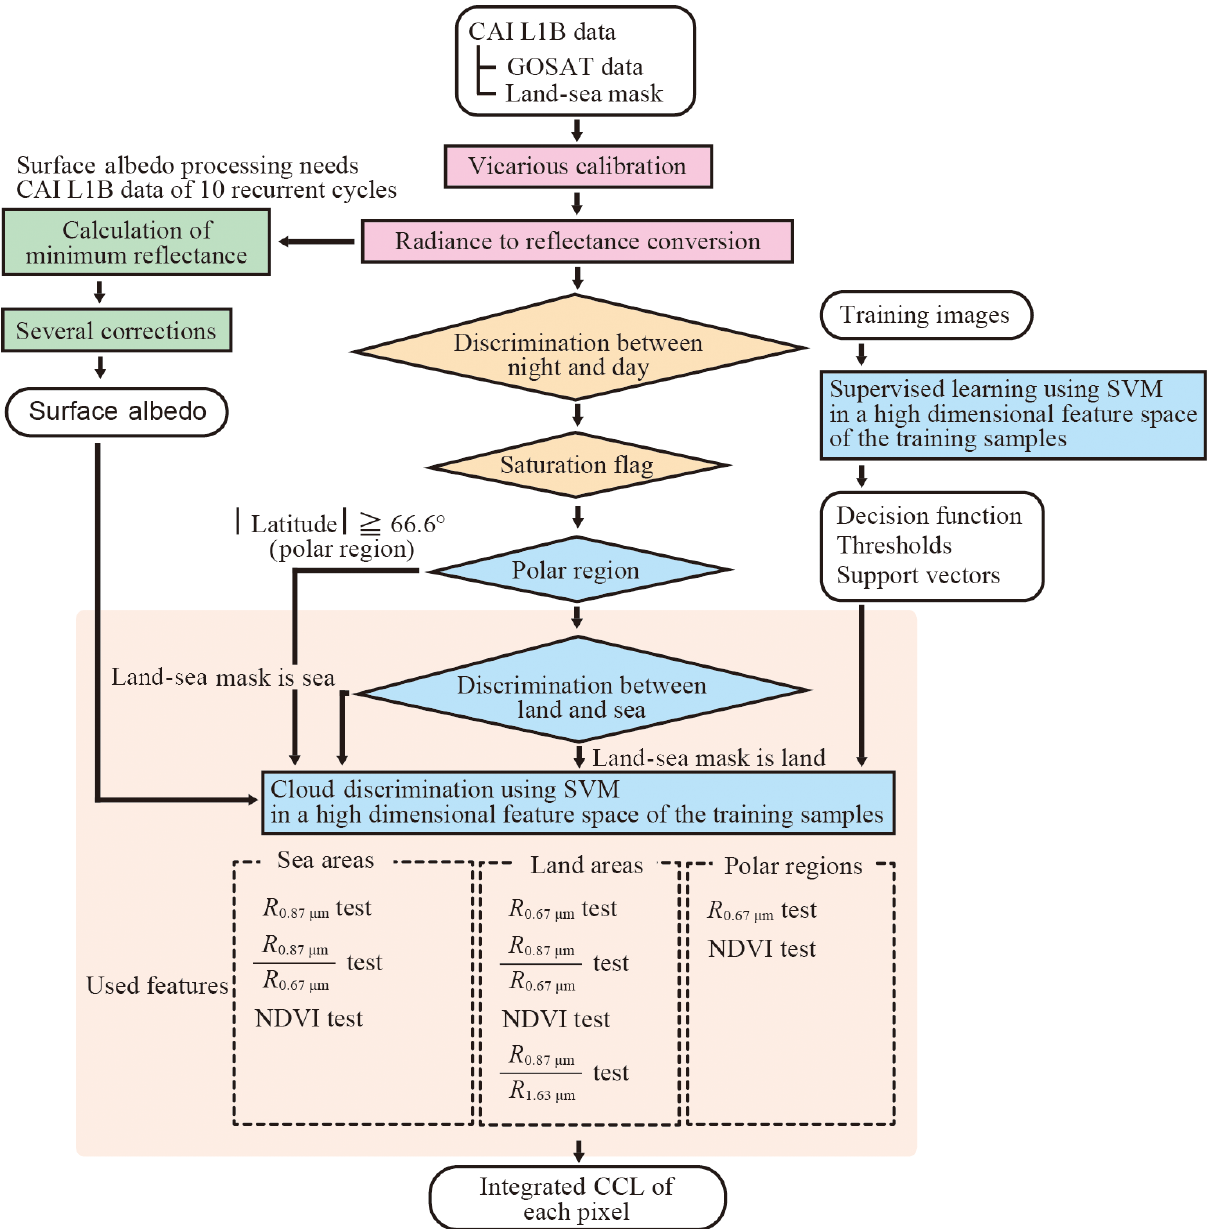
Figure 7. Flow chart for CLAUDIA3–CAI. CCL is clear-sky confidence level, Rwavelength is reflectance, NDVI is normalized difference vegetation